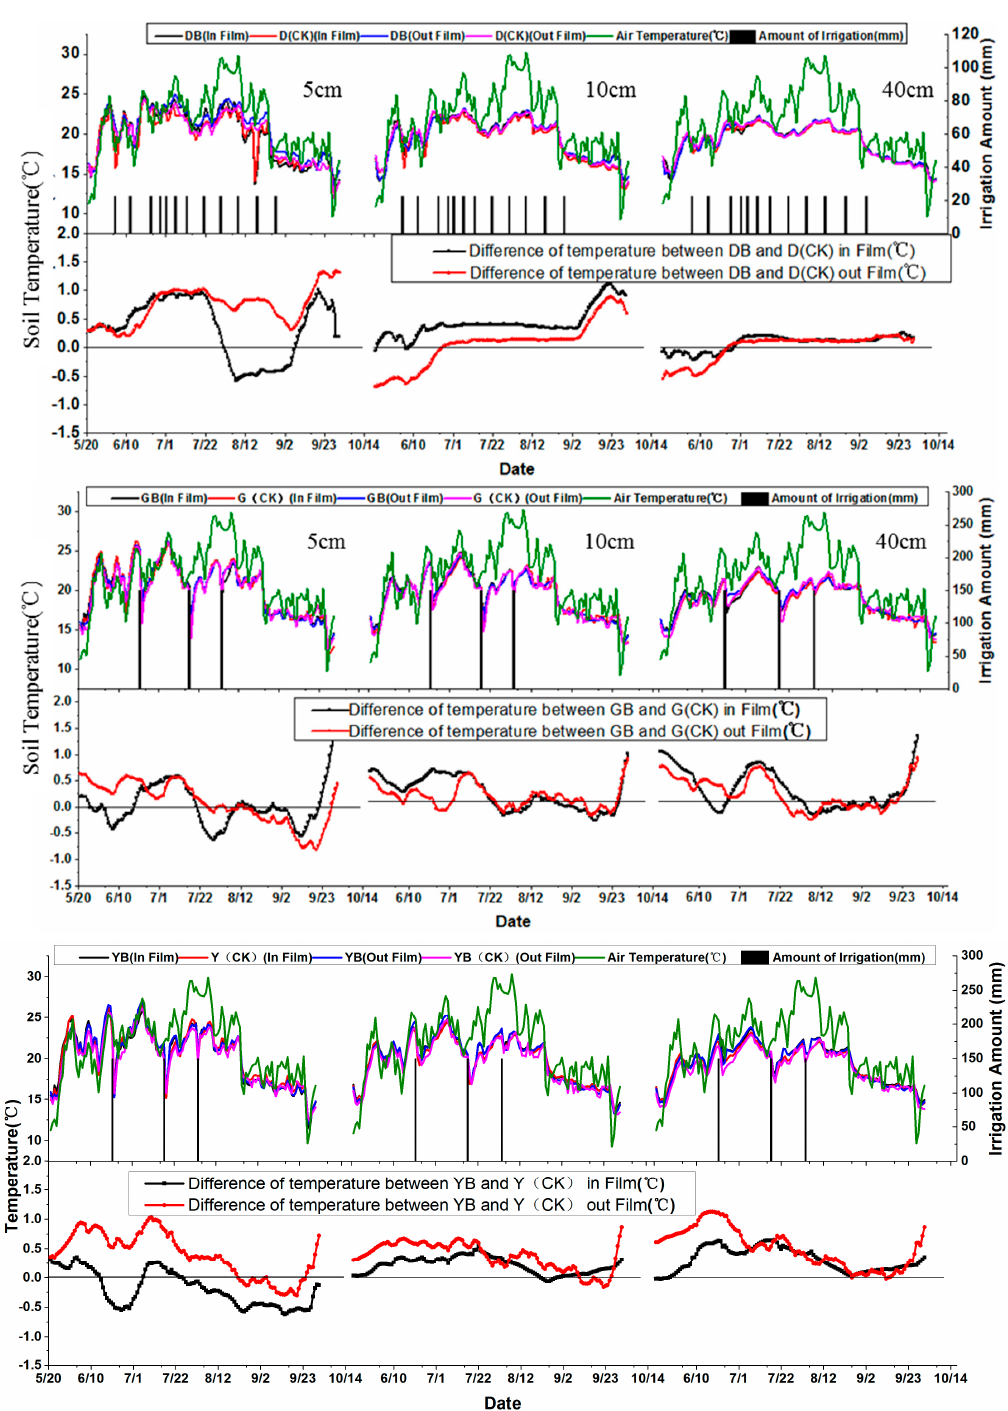
Figure 6. Seasonal dynamic changes of soil temperature in 2016. Note: 5 cm, 10 cm and 40 cm represent of the soil depth of 5 cm, 10 cm and 40 cm.